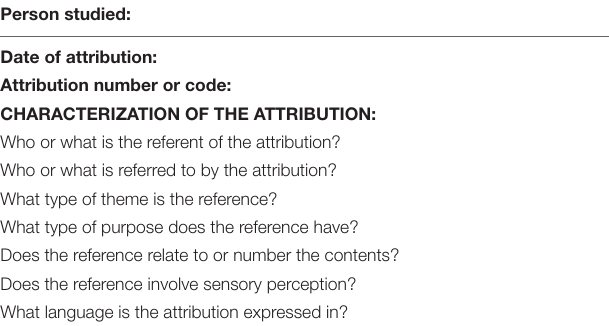
TABLE 4 | Checklist of the synchronic perspective of an attribution.